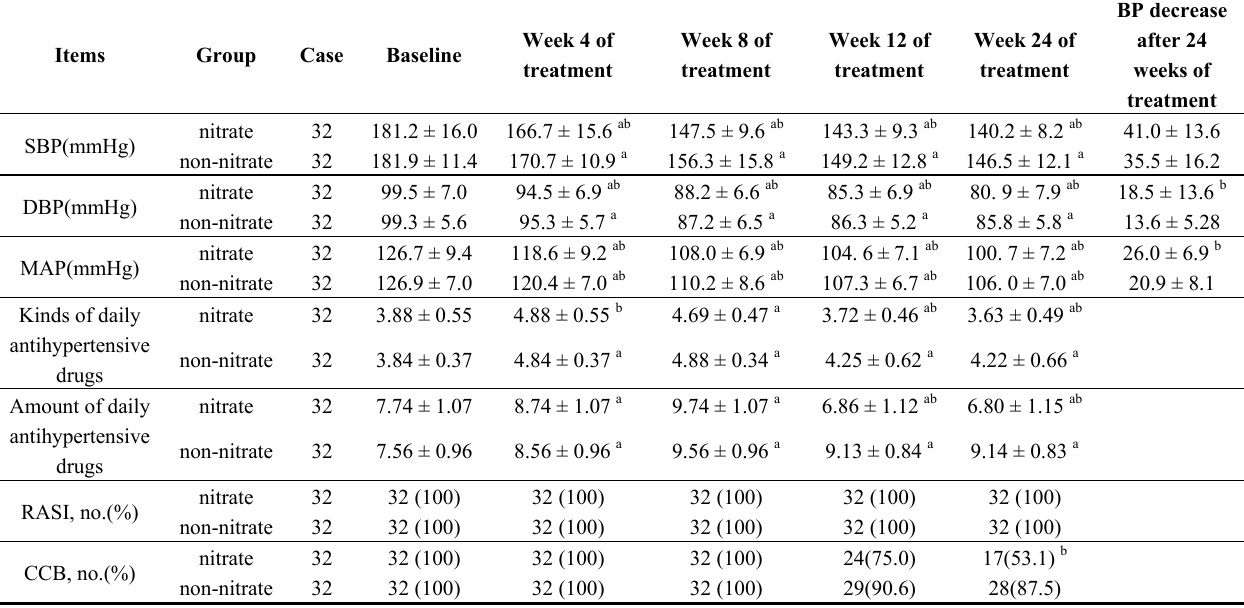
Table 2. Comparison of BP before and after treatment in the two groups.